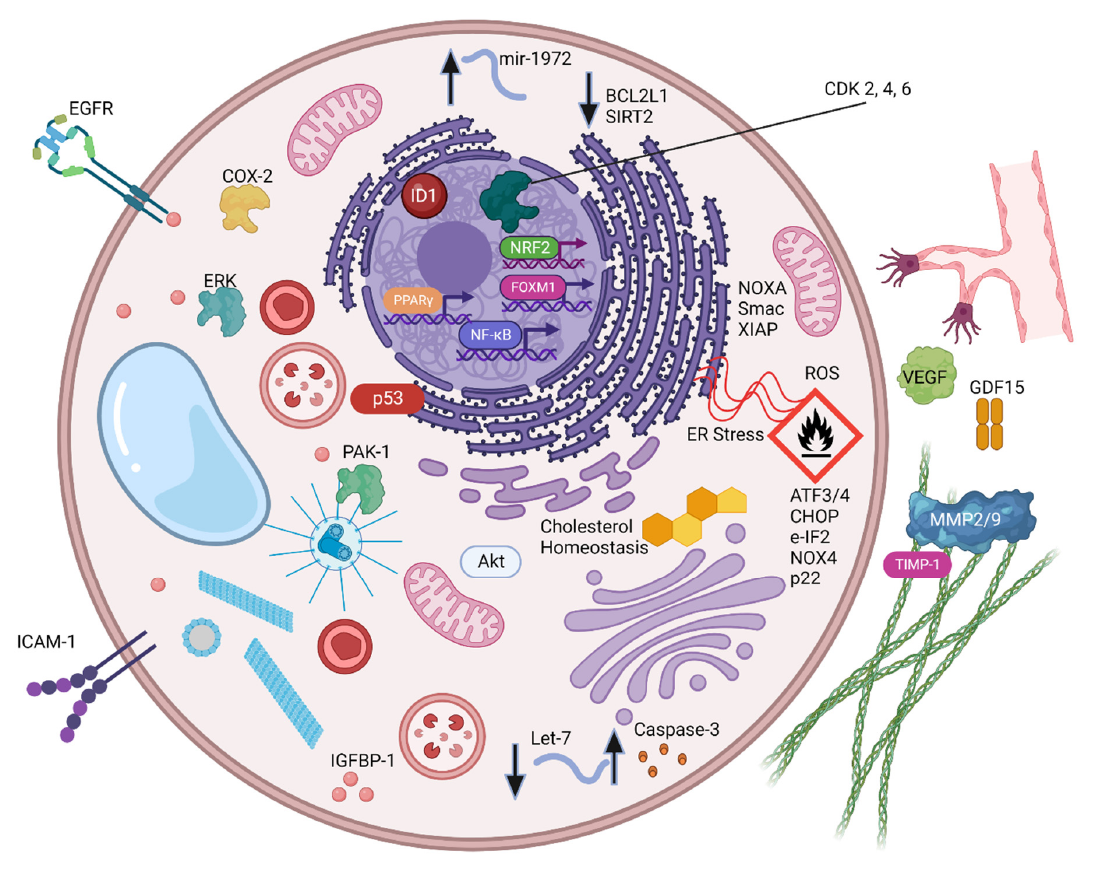
Figure 3. Evidence for CBD combination therapies for cancer. Molecular targets reported to be responsible for the anti-cancer effects of CBD either when used alone or in combination with known cancer therapies are shown. (Created with BioRender.com).